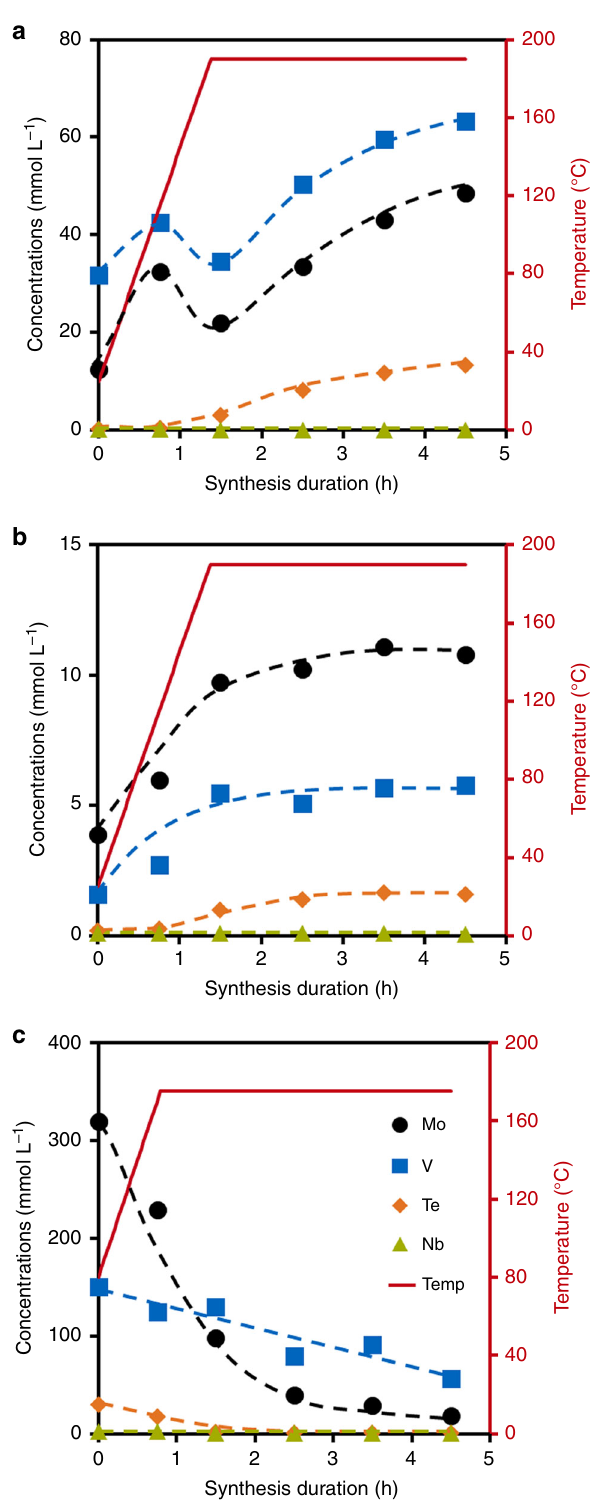
Fig. 7 Composition of fi ltrates extracted from MoVTeNb hydrothermal slurries. Synthesis according to the procedure presented in this work in presence of additives ( a ); reference synthesis as in a , but without additives ( b ); synthesis according to procedure presented in 19 c